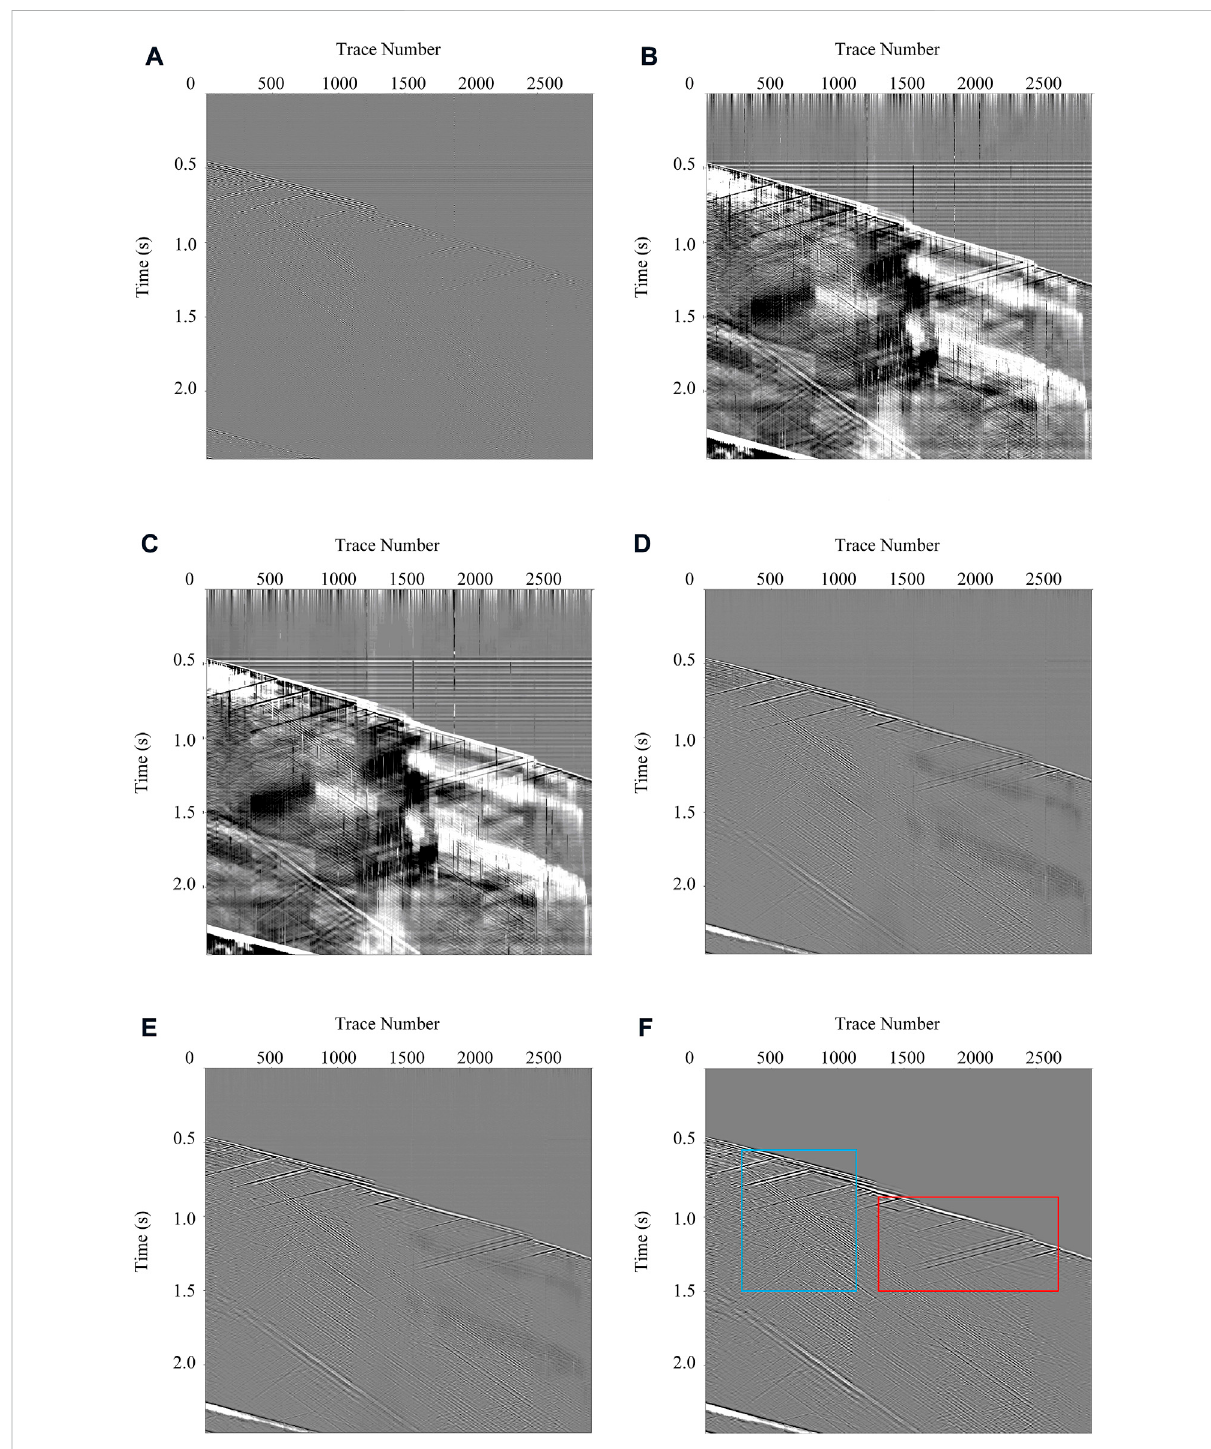
FIGURE 10 Comparisons for the denoising results of the fi eld DAS-VSP record. (A – F) The denoising results for Band-pass fi ltering, Wavelet transform fi ltering, WNNM, DnCNN, U-Net, and MSI-Net,